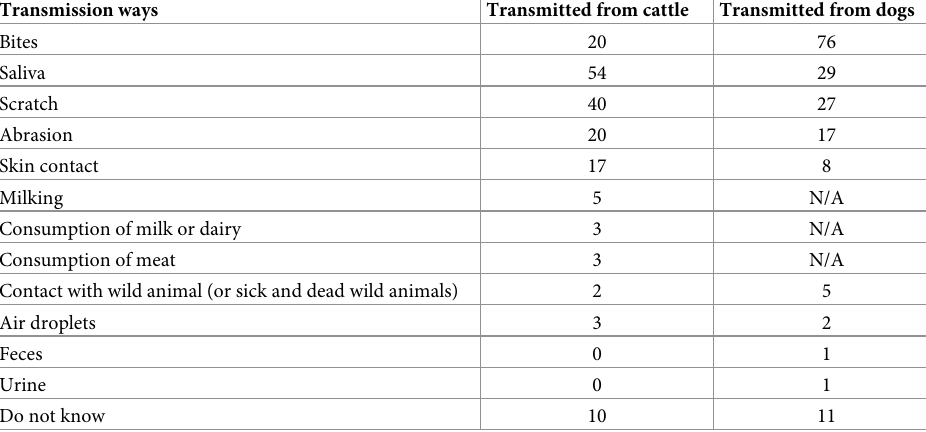
Table 4. Respondent knowledge about rabies transmission (N =